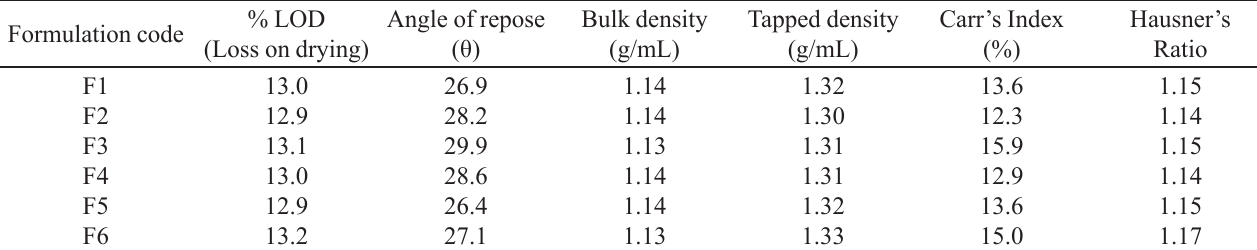
TABLE II - Micromeritic properties of delayed release granules of AMT Formulation code